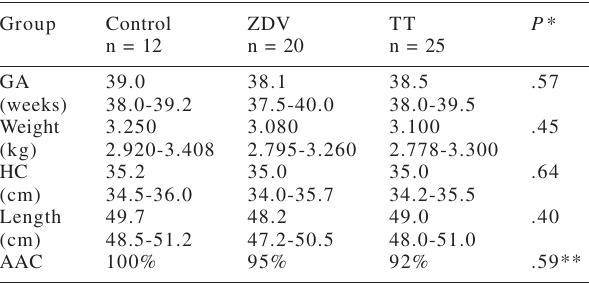
Table 2 - Gestational age (GA), weight, head circumference (HC), body lengths, and adequacy of anthropometric classification (AAC) from the newborn at the time of